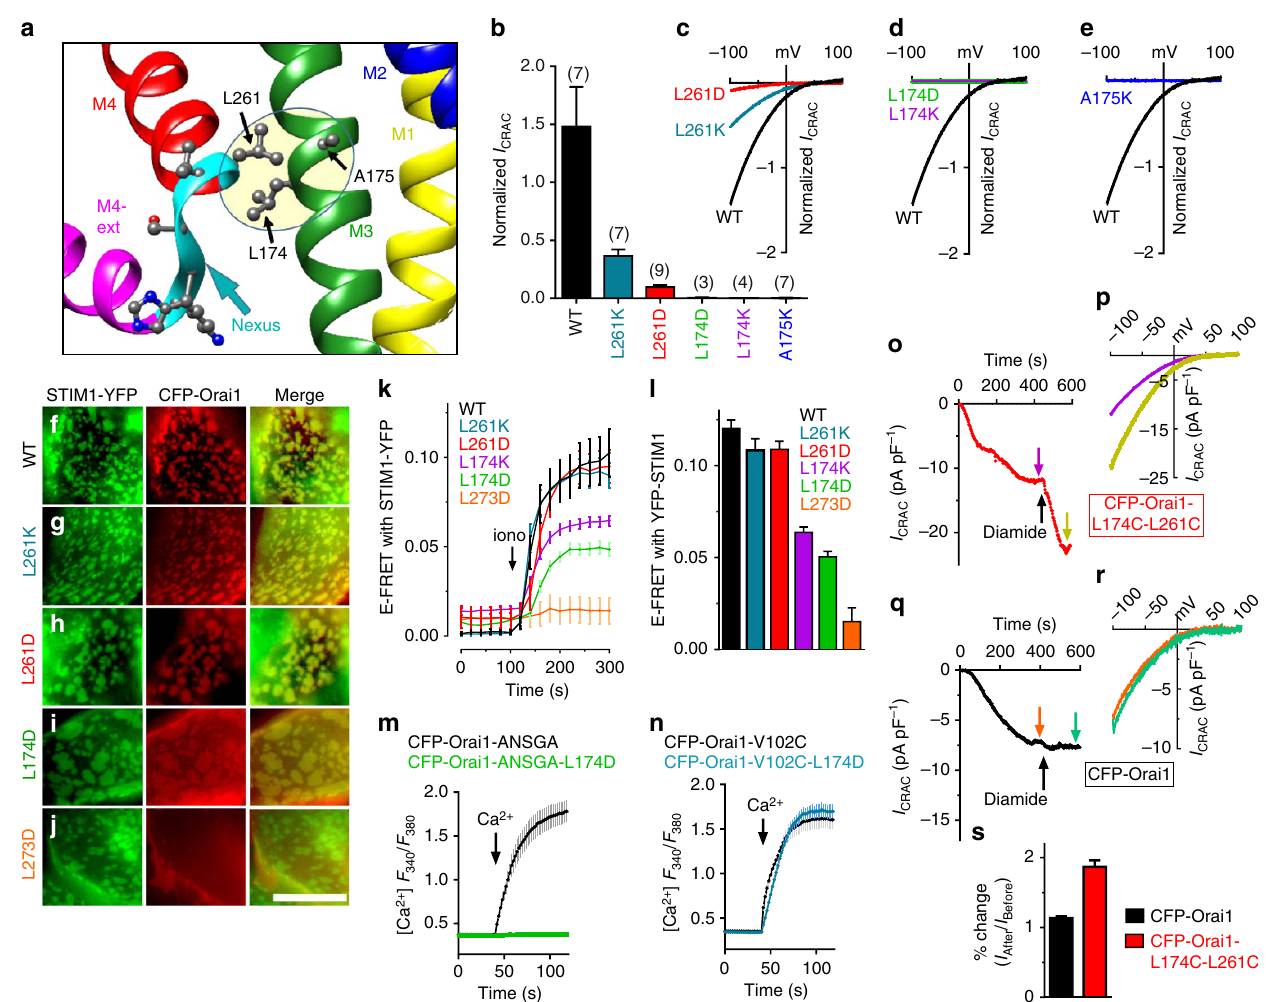
Figure 4 | A critical M4–M3 interaction within Orai1 transduces the binding of STIM1 into channel gating. ( a ) Detail of the M4 (L261) interaction with M3 (L174 and A175) shown as the shaded area. ( b ) Normalized peak currents for L261, L174 and A175 CFP-Orai1 mutants, expressed in stable HEK-STIM1- YFP cells, store-depleted with 10mM BAPTA internal solution. I CRAC measured in 20mM Ca 2 þ at (cid:2) 100mV was normalized for each individual cell to the fluorescence intensity of CFP-Orai1 mutant expression in that cell. ( c – e ) Representative I – V plots of WTand mutant Orai1 channels. ( f – j ) High-resolution imaging of the ER–PM interface in HEK-STIM1-YFP cells transiently expressing WT ( f ), L261K ( g ), L261D ( h ), L174D ( i ) and L273D ( j ), 3min after 2.5 m M ionomycin treatment. Scale bar, 5 m m. ( k ) E-FRET between STIM1-YFP and CFP-Orai1 using the same Orai1 mutants expressed within HEK-STIM1-YFP cells as in b . ( l ) Summary of E-FRETpeak values after store depletion for the Orai1 mutants shown for k . ( m ) Fura-2 Ca 2 þ responses in store-replete HEK cells expressing CFP-Orai1-ANSGA (black) or CFP-Orai1-ANSGA-L174D (green). ( n ) Fura-2 Ca 2 þ responses in store-replete HEK cells expressing CFP-Orai1- V102C (black) or CFP-Orai1-V102C-L174D (blue). ( o – r ) Whole-cell recordings of stable HEK-STIM1-YFP cells expressing CFP-Orai1-L174C/L261C ( o , p ) or CFP-Orai1 ( q , r ). ER stores were depleted with 10mM internal BAPTA. A unit of 500 m M diamide was applied (arrow) after I CRAC development. I – V plots ( p , r ) are shown for current before and after diamide as shown in o , q (arrows). ( s ) Summary of diamide-induced current enhancement in o , q . All values are means ±